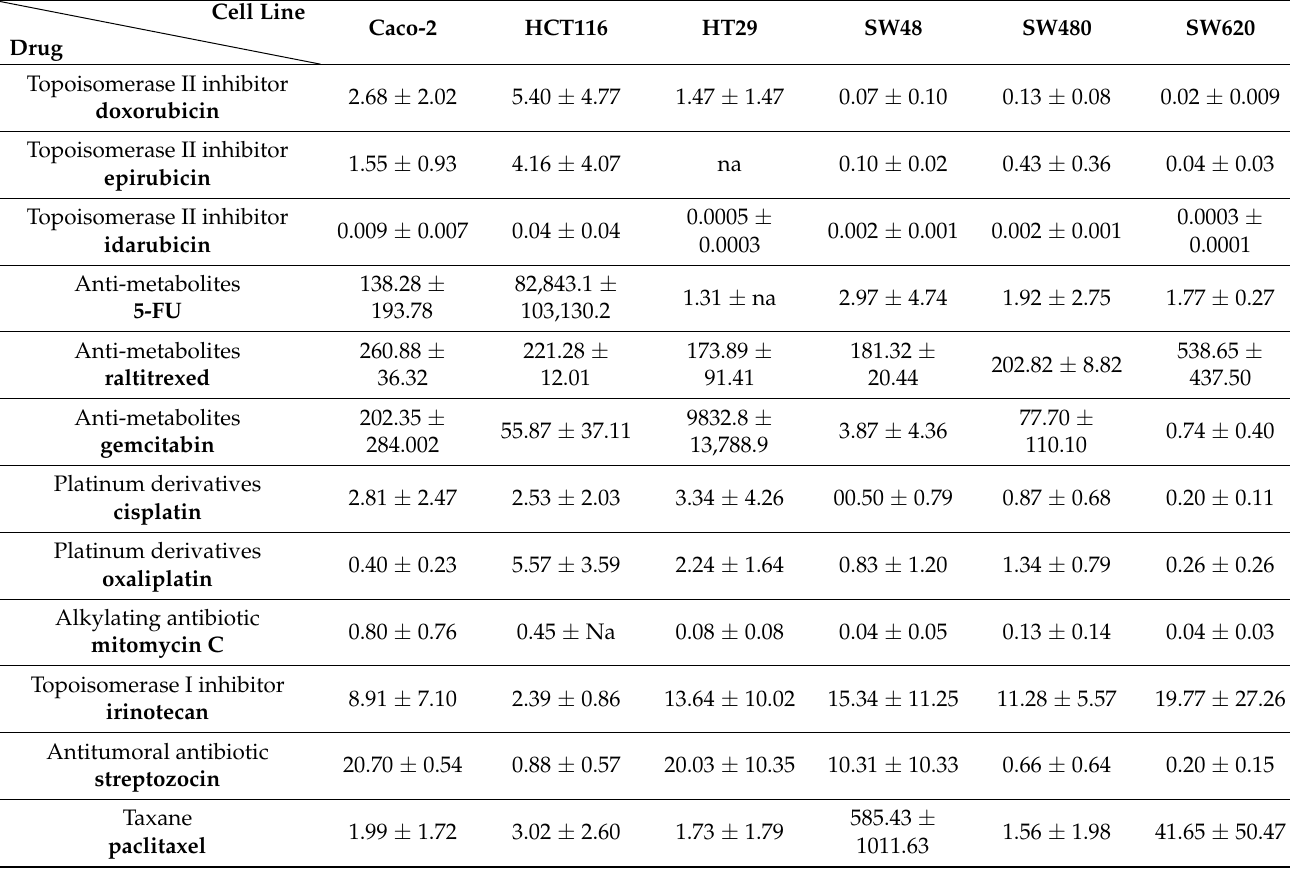
Table 2. IC 90 values (mean ± standard deviation) obtained for the 6 colorectal cancer cell lines and the 12 antitumoral agents. The bold is to underline the name of the drug, distinguish from the family of the